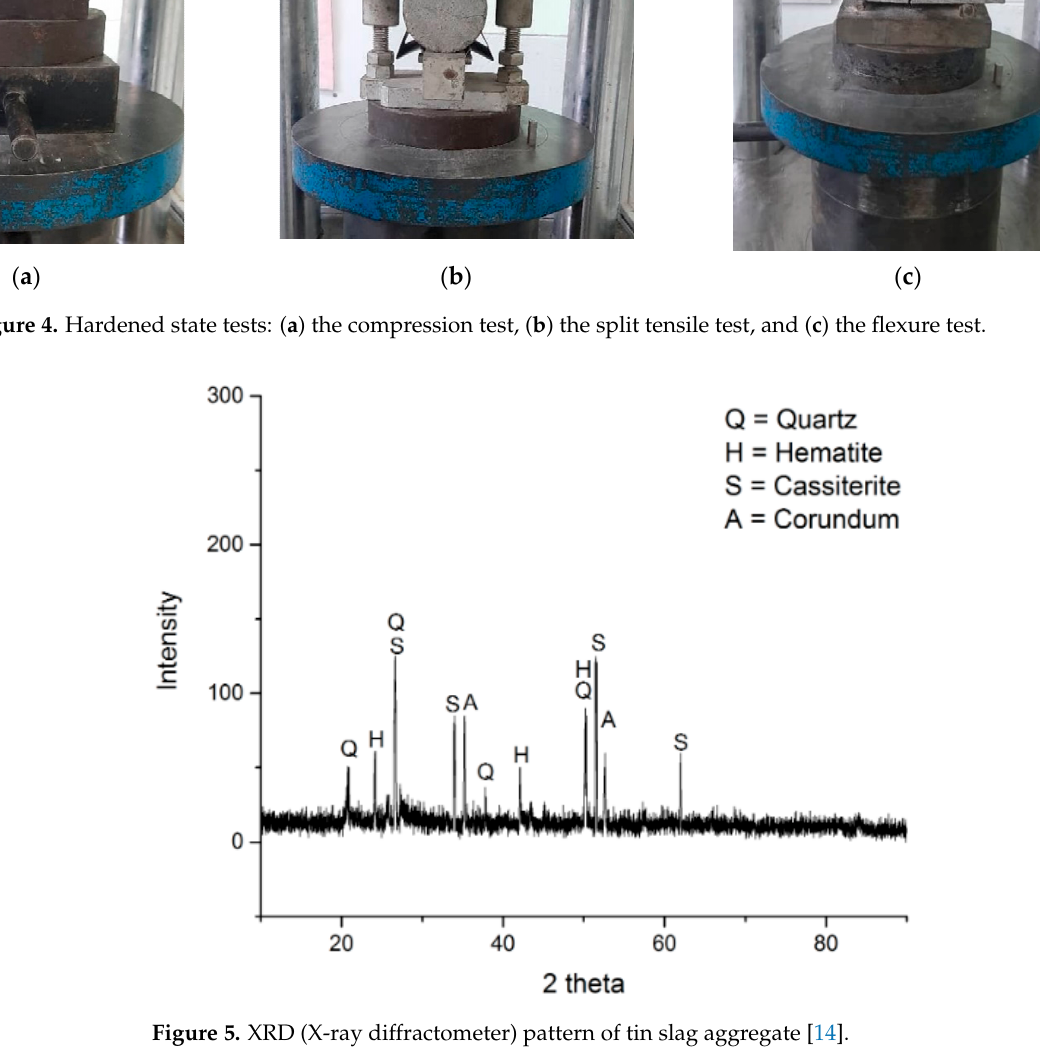
Figure 5. XRD (X-ray diffractometer) pattern of tin slag aggregate [14].